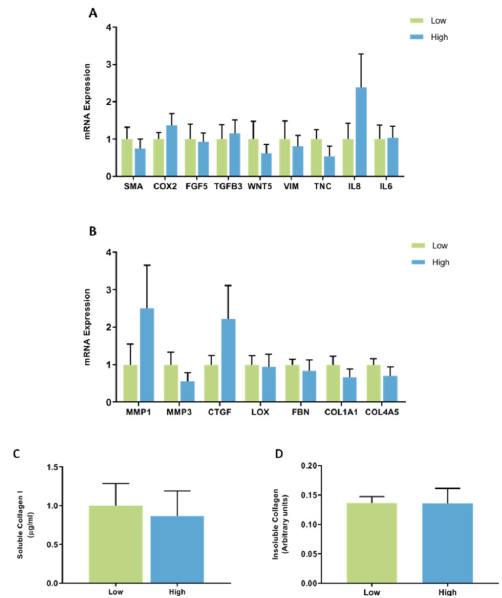
Figure 3. mRNA expression and collagen production in mammary fibroblasts isolated from women with high and low mammographic density. Messenger RNA expression of cancer-associated genes ( A ) and genes involved in extracellular matrix regulation and collagen production ( B ) mea- sured by RT-PCR in human mammary fibroblasts from women with high ( n = 7) and low ( n = 9) mammographic density. mRNA expression normalised to HPRT1 expression and presented as rela- tive expression where the average for untreated control is 1. Collagen production was measured using collagen 1 ELISA ( C ) and insoluble collagen measured by sirius red staining ( D ). Data presented as mean + SEM with statistical analysis performed using a linear mixed-effects model Tukey’s post hoc